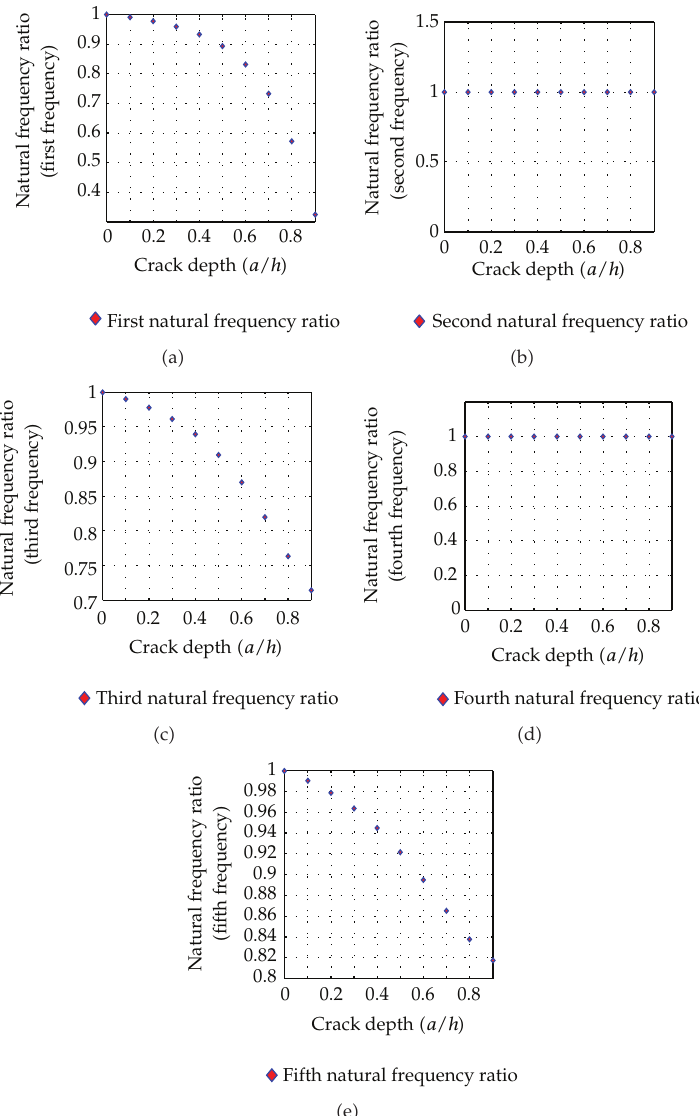
Figure 7: Variation of natural frequency ratio with the crack depth of a simply supported beam (cid:6) L 1 /L (cid:5) 0 . 5 (cid:7) : (cid:6) a (cid:7) first frequency, (cid:6) b (cid:7) second frequency, (cid:6) c (cid:7) third frequency, (cid:6) d (cid:7) fourth frequency, and (cid:6) e (cid:7) fifth